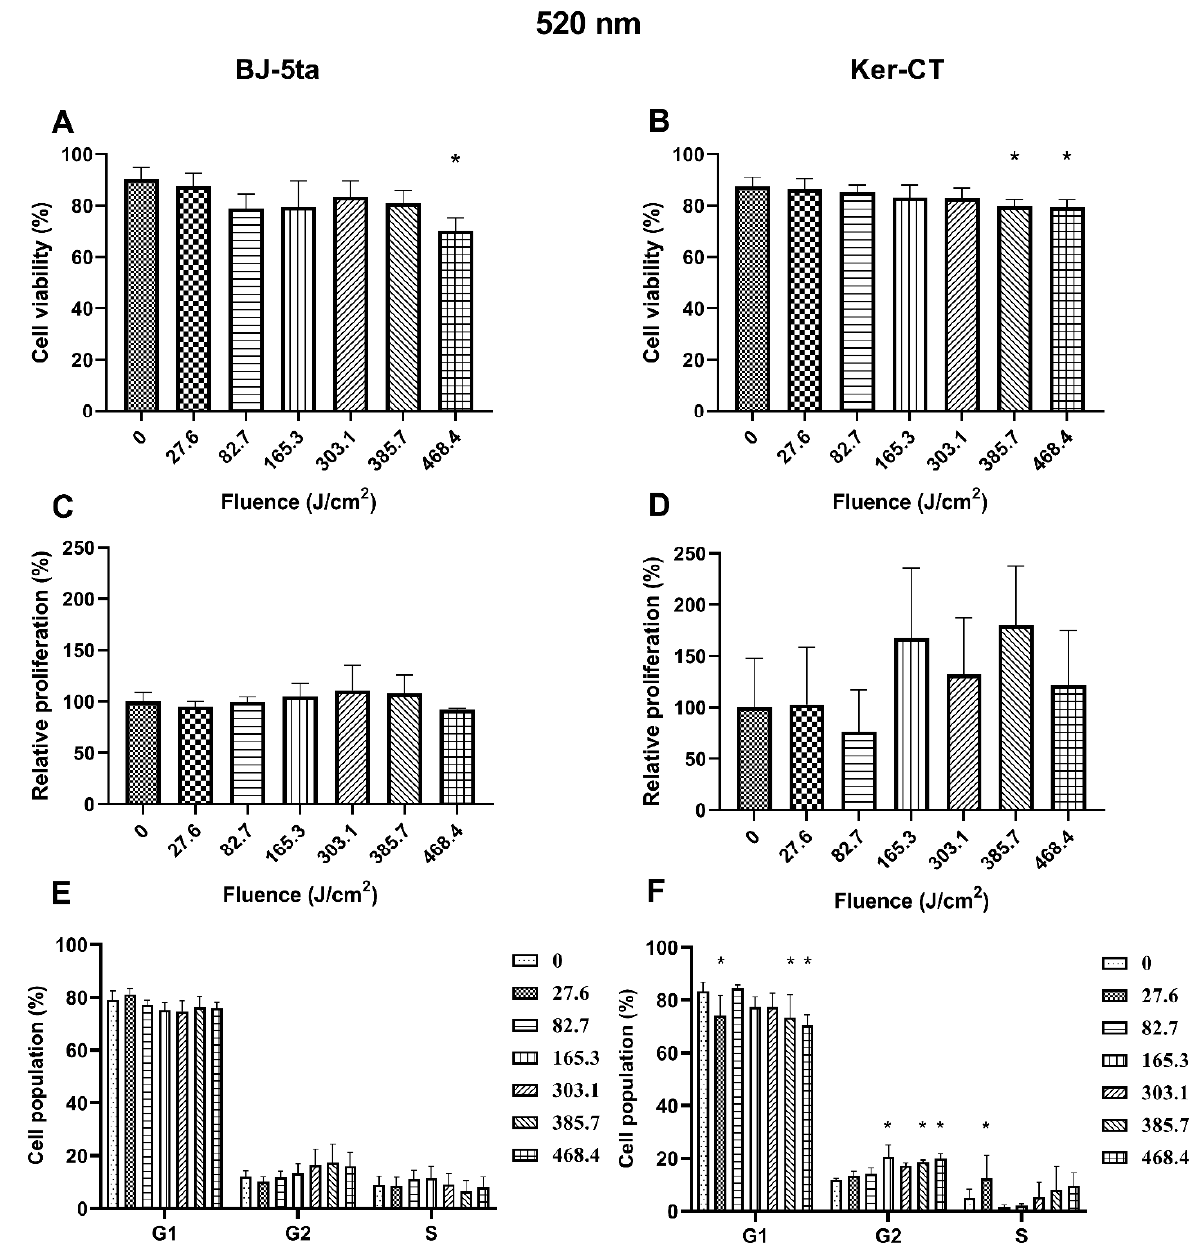
Figure 3. Effects of 520 nm irradiation on BJ-5ta fibroblasts and Ker-CT keratinocytes. ( A , B ) Viability using Annexin V-APC and PI. ( C , D ) Relative proliferation using an anti-Ki67-APC antibody. ( E , F ) Cell cycle distribution using FxCycle PI/RNase Staining Solution. * p <